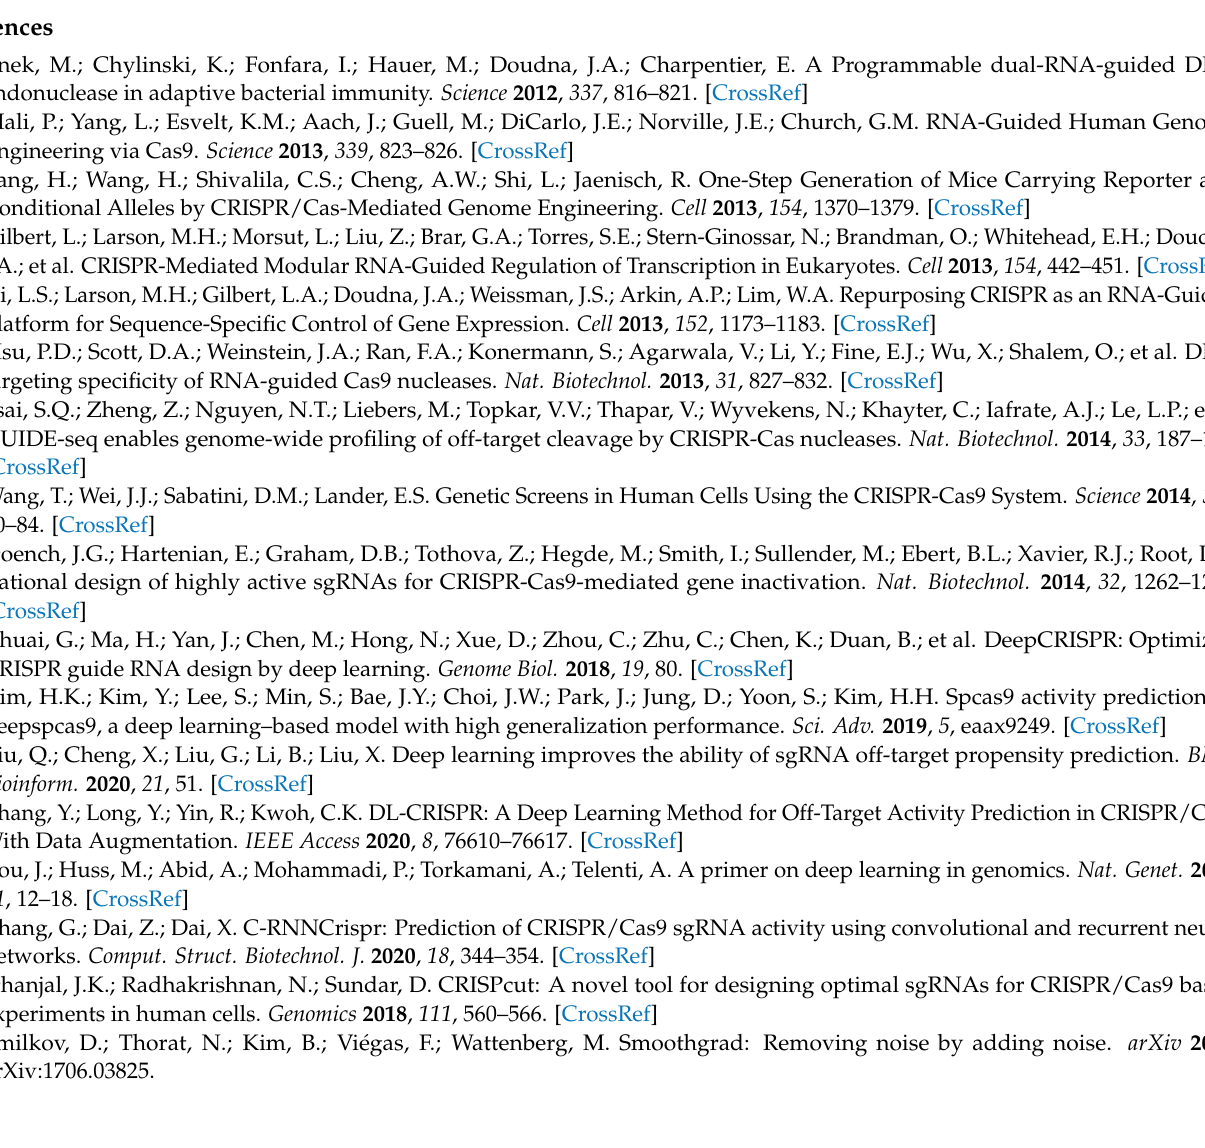
Figure S2: Mismatch tolerance across the length of the guide RNA; Figure S3: gap tolerance across the length of the guide RNA; Figure S4: Predictive performance of various neural networks tested; Figure S5: Average class activation maps for the VEGFA2 locus off-targets; Figure S6: Architecture used for the dual classification and regression tasks; Table S1: Base-position pairs that tolerate the most mismatches; Table S2: Gap tolerance across the length of the guide